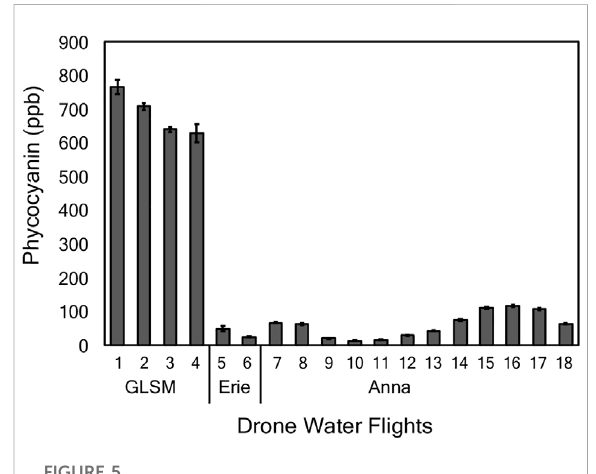
FIGURE 5 Phycocyanin (PC) values shown in parts per billion (ppb) for the 18 fl ights collected at the three lakes in fi eld year 2019. Four fl ights were collected from GLSM, two from Lake Erie, and 12 from Lake Anna. The mean PC concentration at GLSM, Erie, and Anna was 687, 38, and 62 ppb, respectively. The error bars represent standard error of the mean ( n = 10) for the ten transect tubes collected for each fl